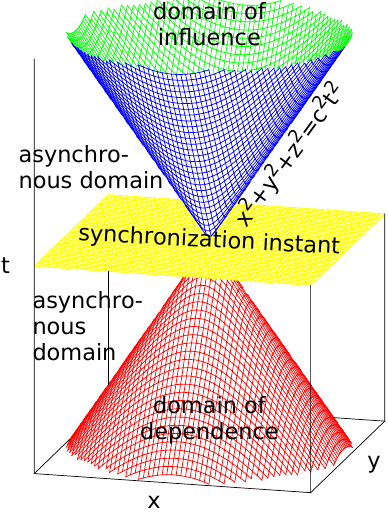
Figure 3. Dependence and influence cones in Minkowski space.